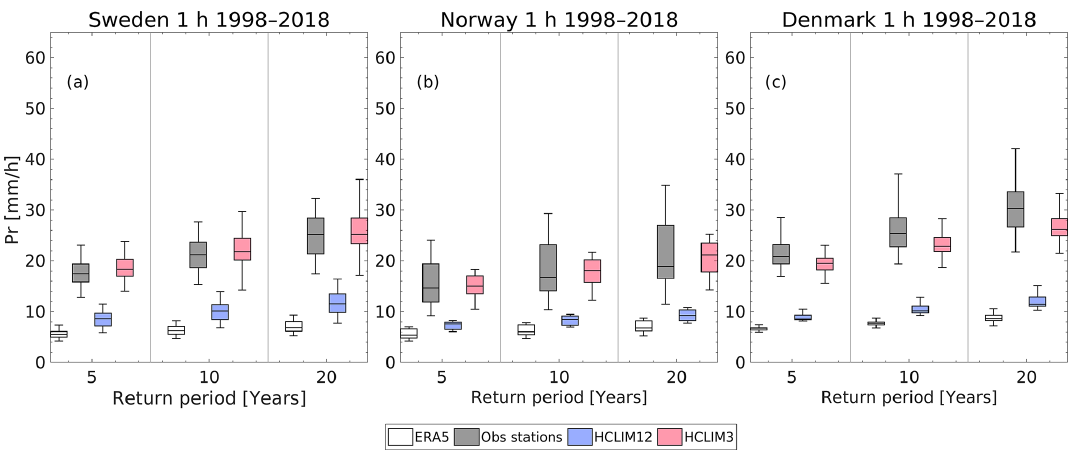
Figure 8. Same as in Fig. 3 but for hourly return levels in (a) Sweden, (b) Norway, and (c) Denmark in HCLIM12, HCLIM3, and observa- tional datasets. The label of Obs stations refers to the AM